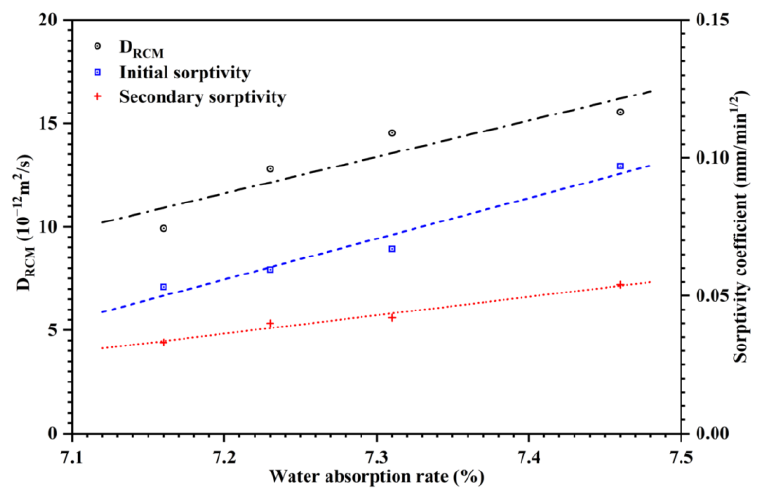
Figure 9. The relationship between sorptivity coefficient, water absorption rate and chloride diffusion coefficient of